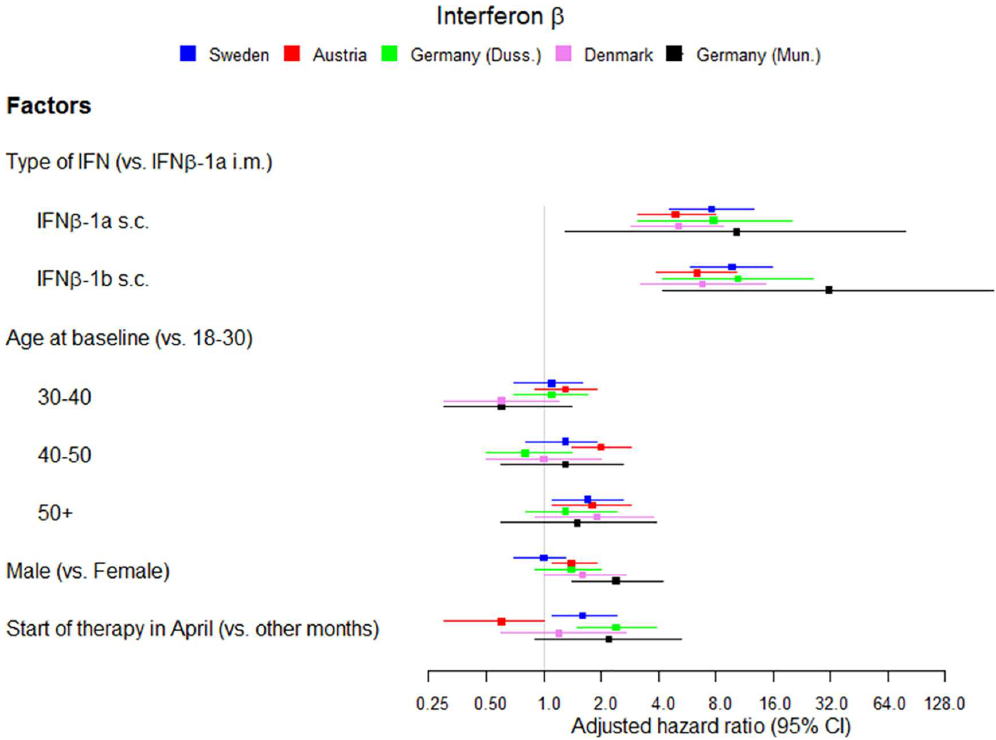
Fig 4. Multivariate risk factors for anti-IFN β ADA development. Multivariate risk factors for anti-IFN β ADA development in each cohort, adjusted on assay method at the last visit in Sweden and Austria.